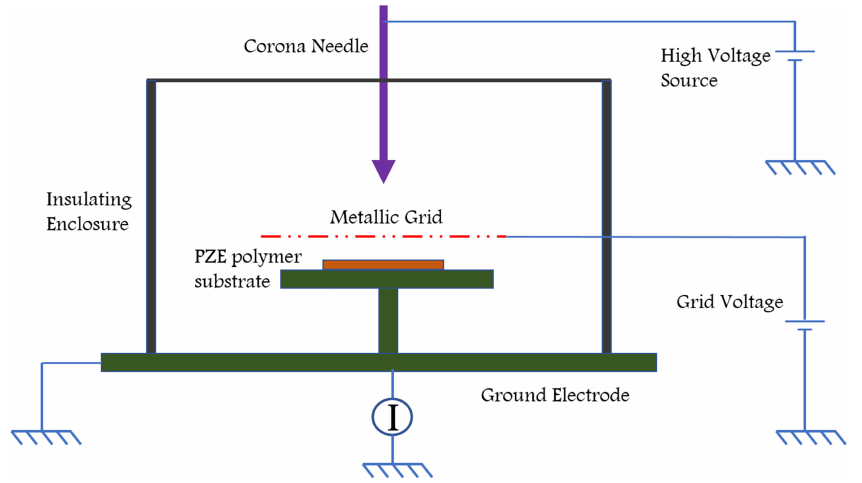
Figure 4. Schematic representation of a Corona poling